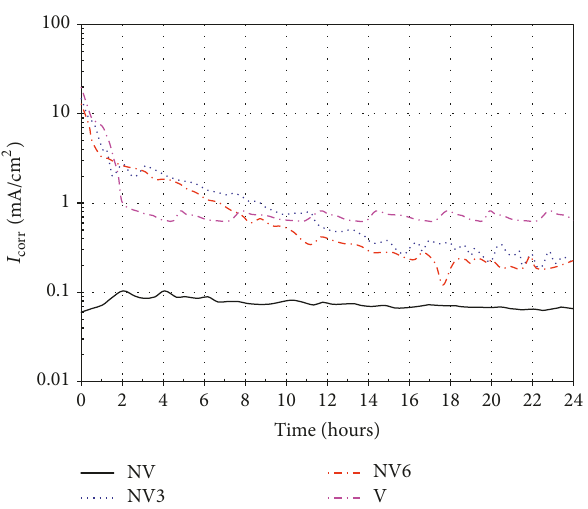
Figure 5: 𝐼 corr variation versus time for Ni in V-rich molten salts at 700 ∘ C.